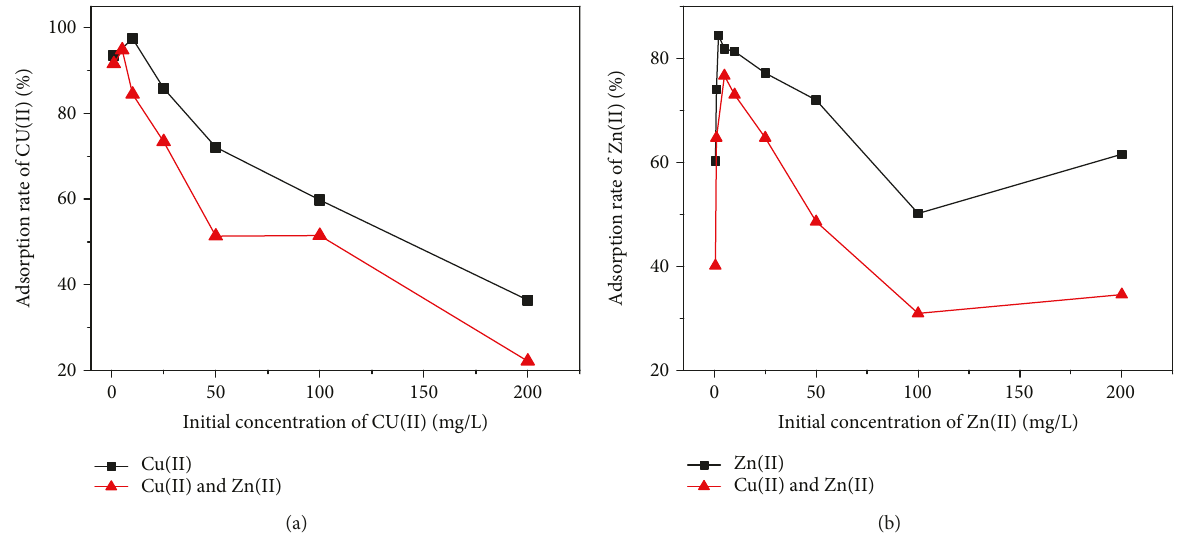
Figure 8: The adsorption rate of single-metal solution and binary-metal solution: (a) adsorption rate of Cu(II) and (b) adsorption rate of Zn(II).